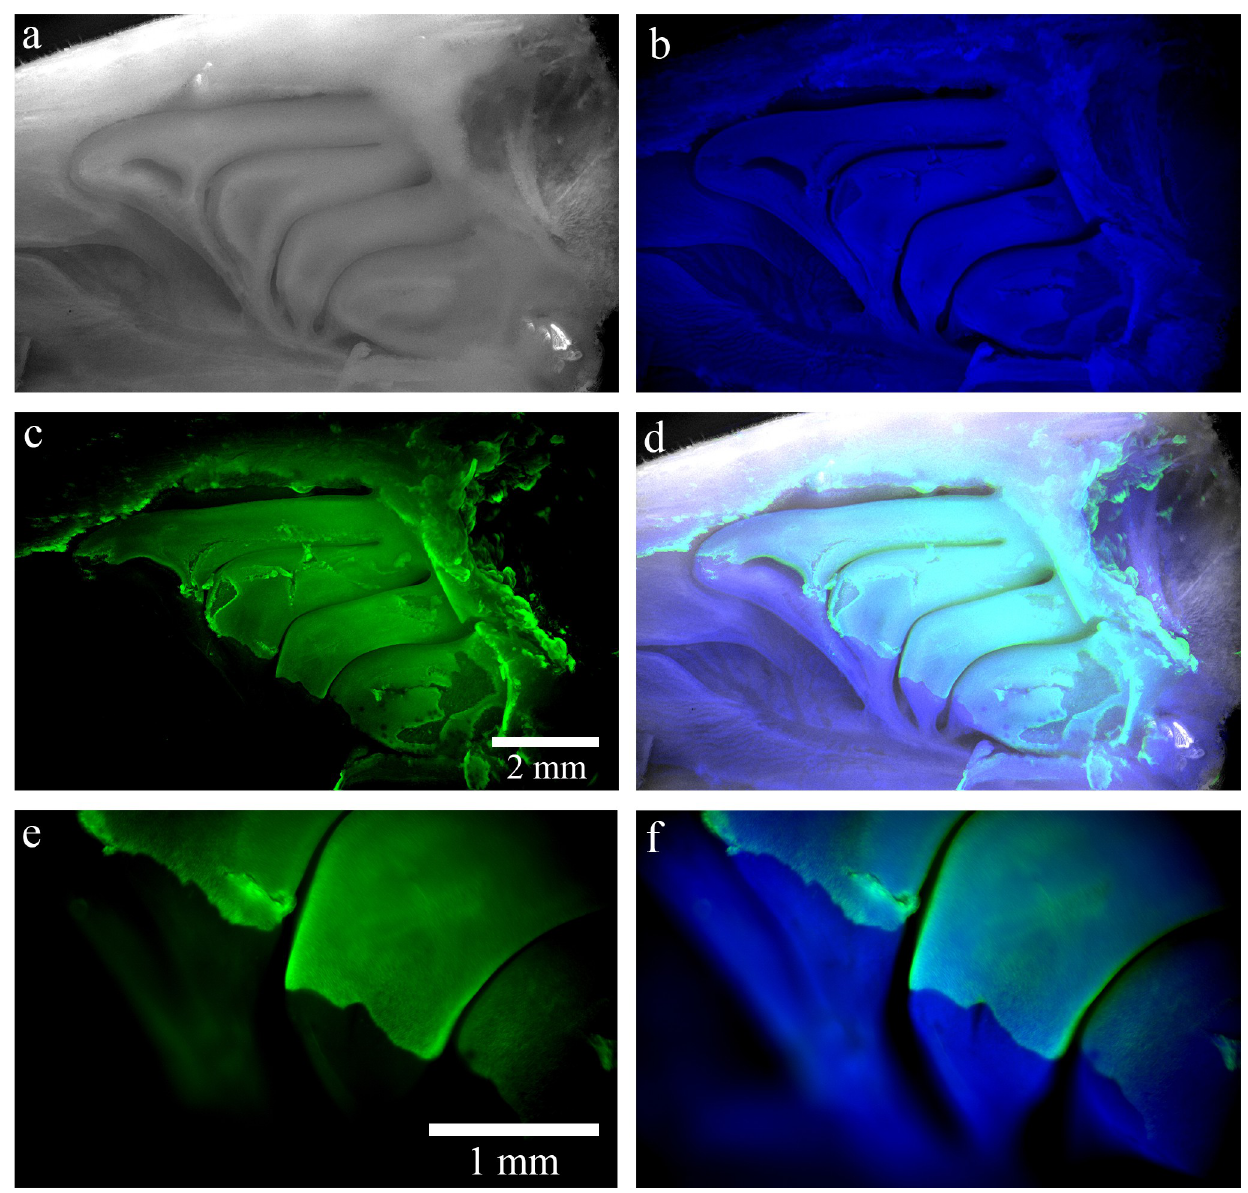
Fig 7. Direct immunostaining on ethmoid turbinates. The morphology of whole ethmoid turbinates was visible on bright field (BF) (a), and by DAPI staining (b). The OE was highlighted by immunostaining with Tuj-1 (c and e). The merge of Tuj-1 (green) and DAPI (blue) with or without BF (gray) indicated the olfactory boundary (d and f). The photos were acquired using a fluorescence macroscope with 1.6X objective for (a-d) and 5X objective for (e, f).